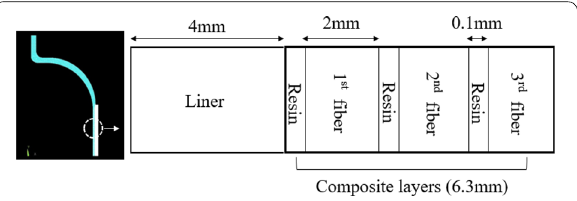
Figure 20 Analysis model of the curing process